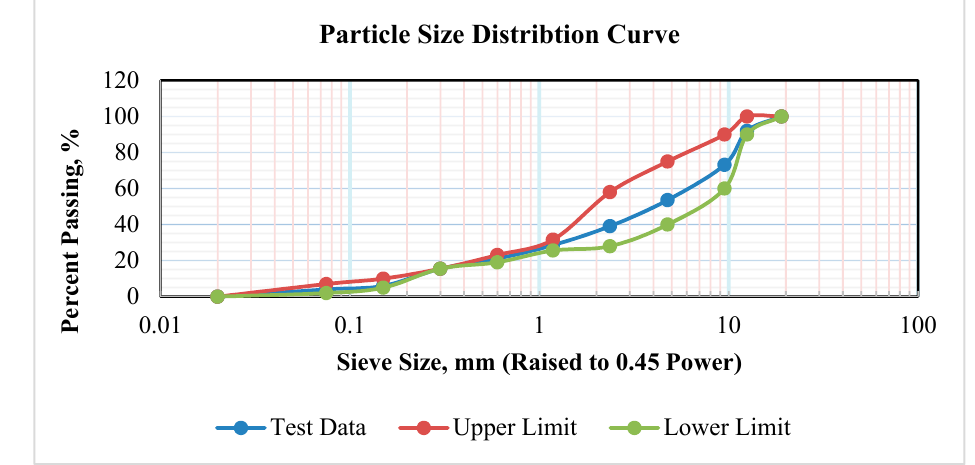
Figure 1. Particle size distribution curve.